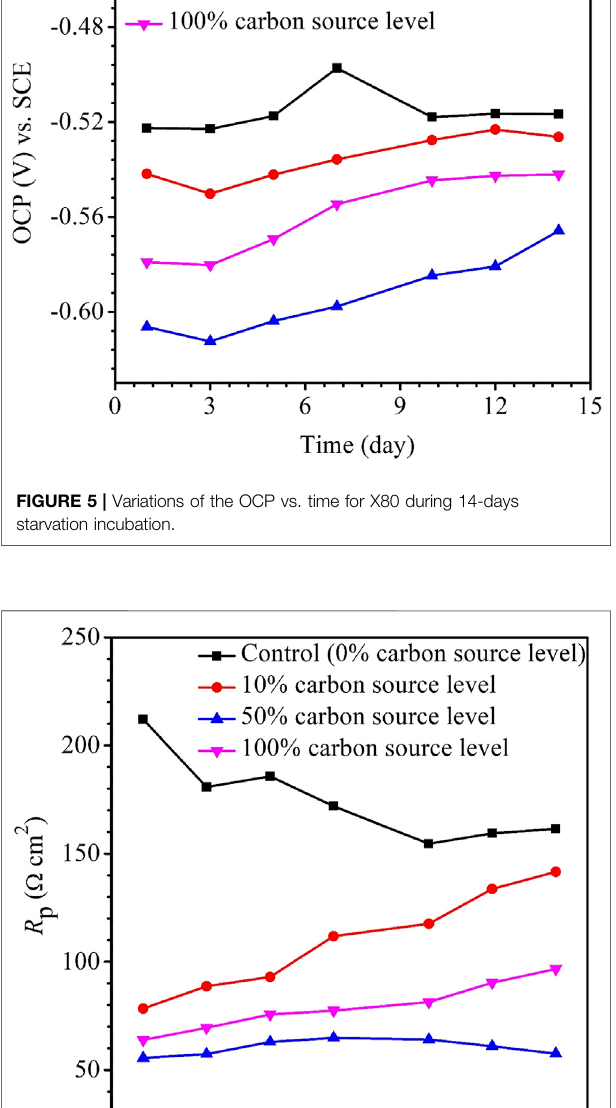
Frontiers in Materials |